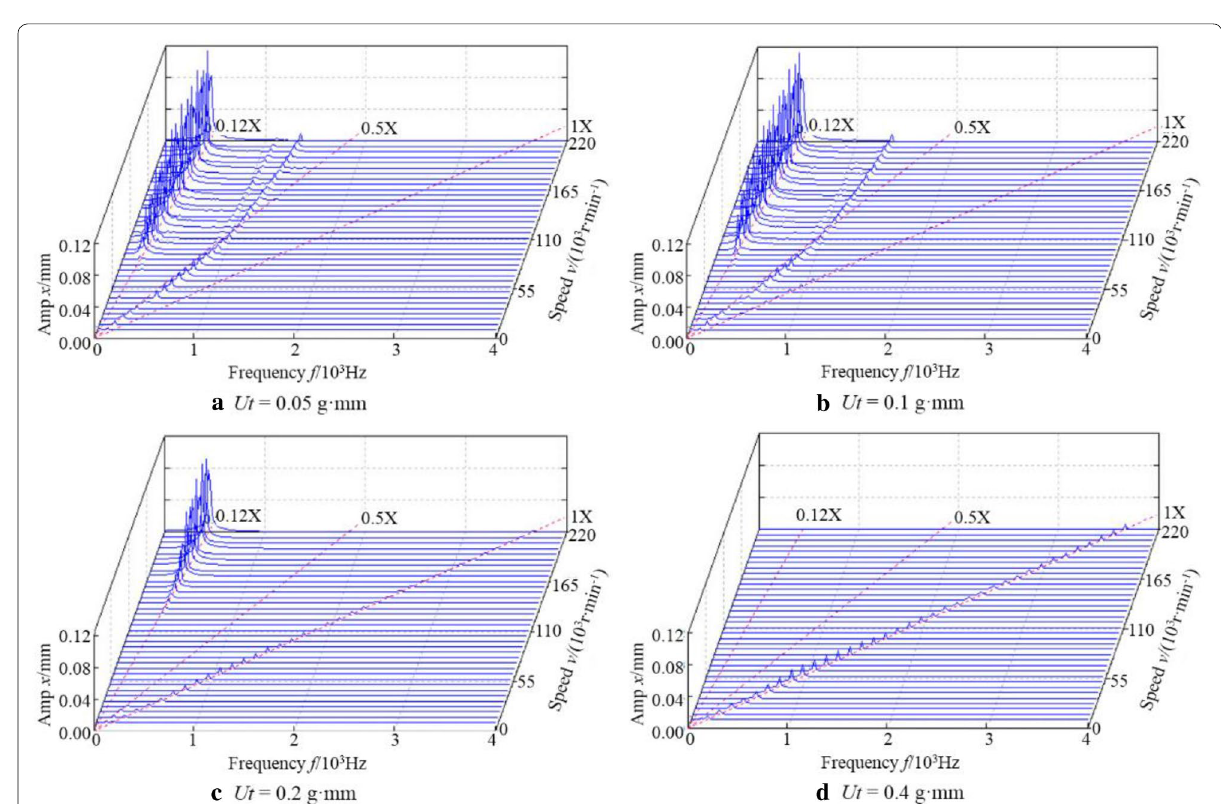
Figure 6 Waterfall plots of stn 20 for four difference unbalance amplitudes in TW nose of